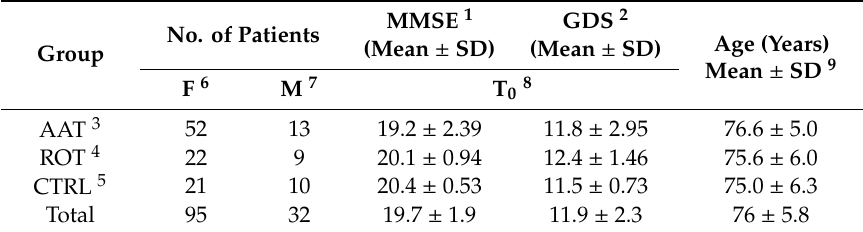
Table 2. Summary of the characteristics of the study population. No. of Group